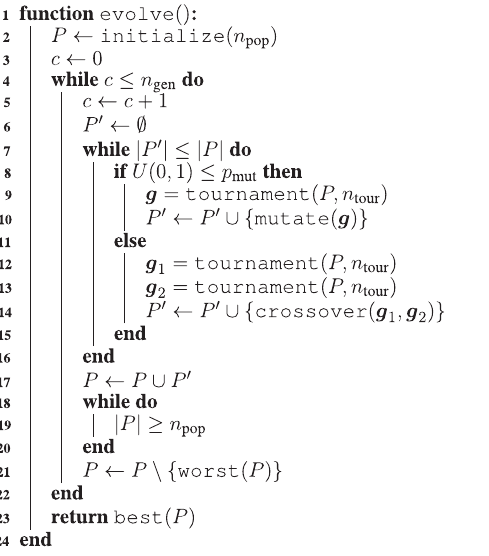
Algorithm 2: The EA for the optimization of the morphology.